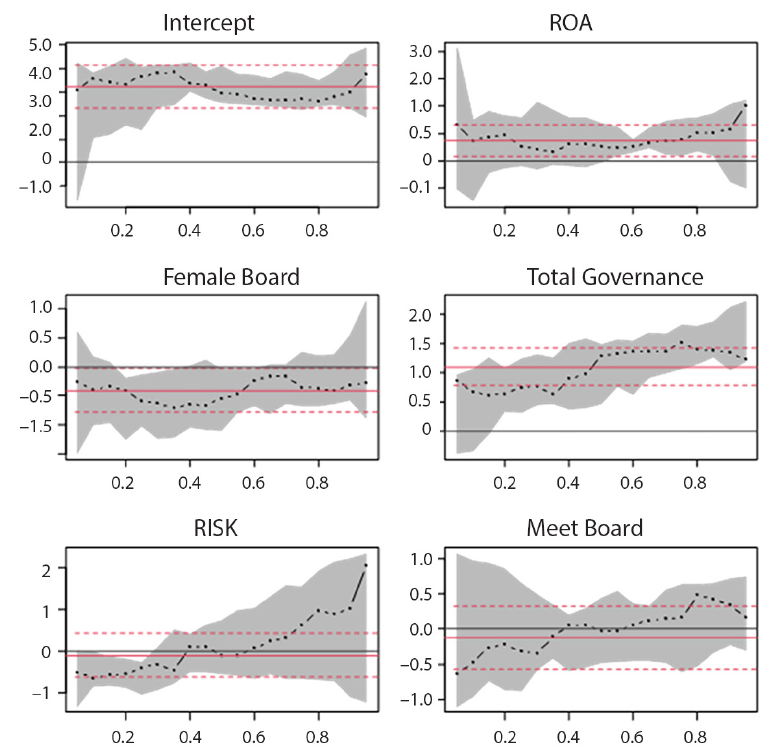
Figure 2. Quantile regression